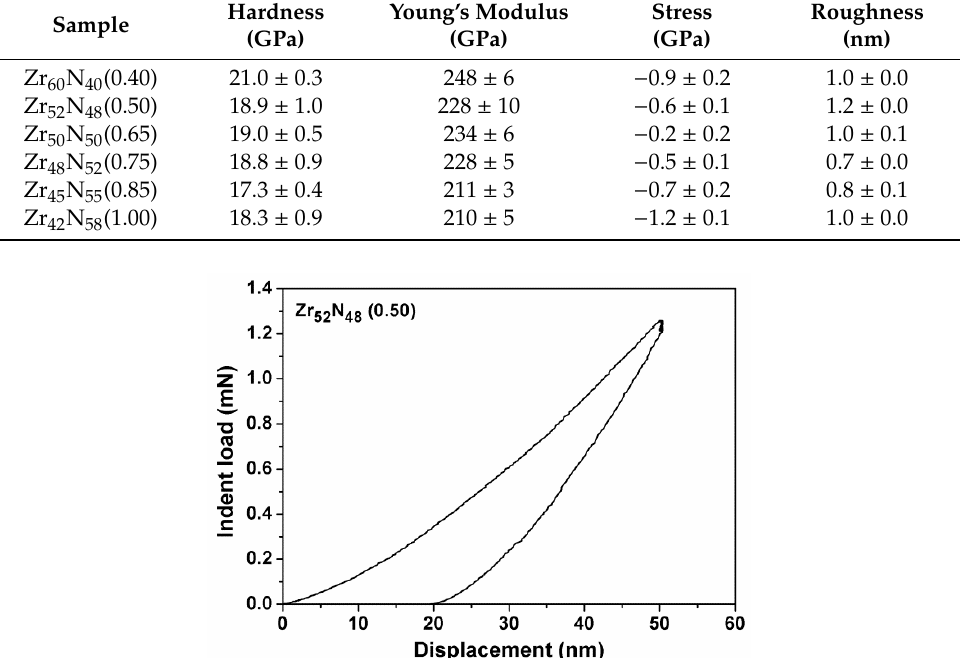
Figure 8. Typical load-displacement curve of nanoindentation tests.